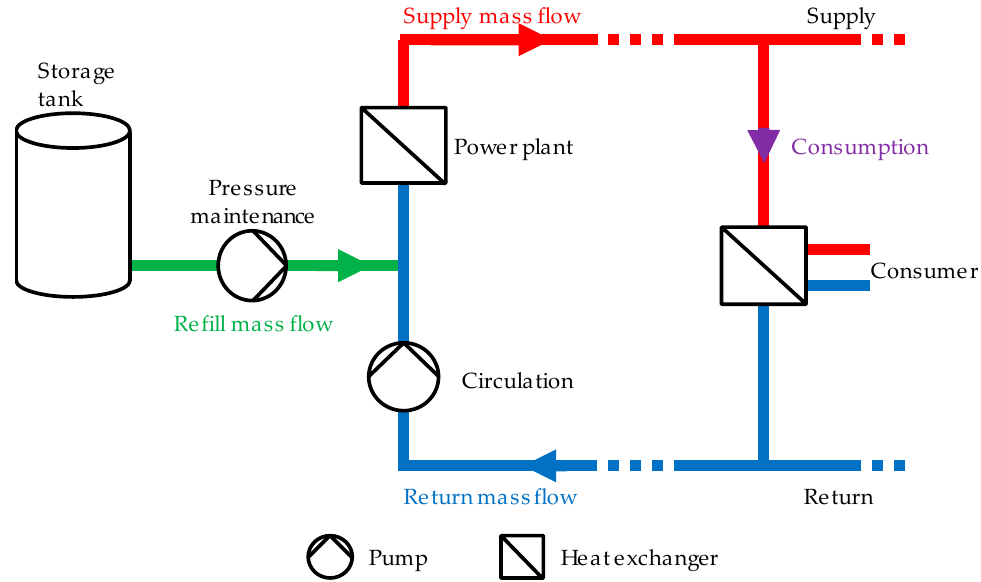
Figure 1 . Schematic representation of a district heating network (Reprinted with permission from Ref. [3]. 2022, Vahldiek).